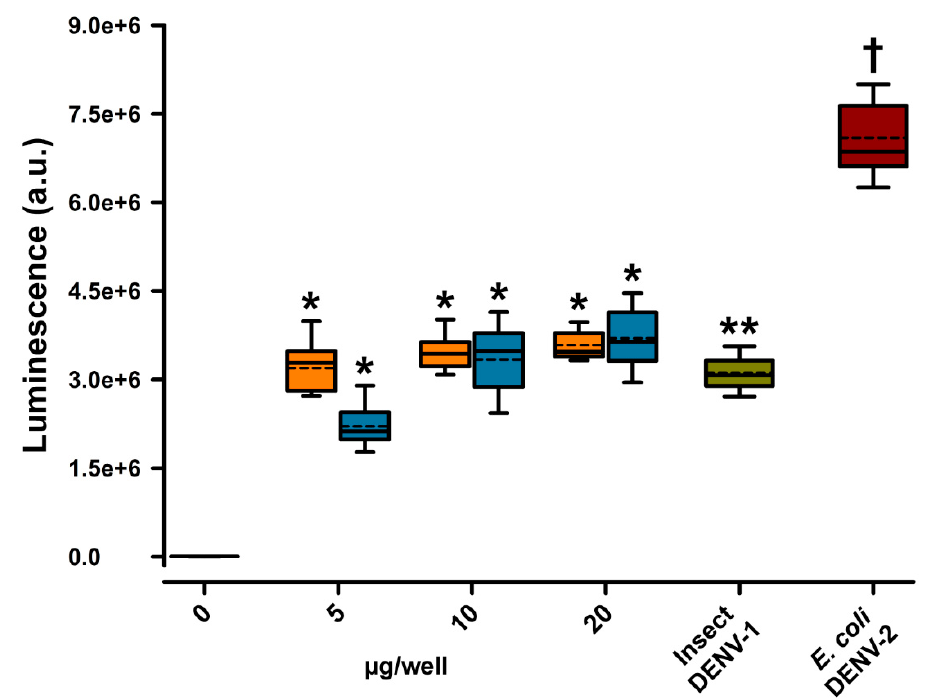
Figure 3. Recognition of synthDENVElope proteins by a monoclonal anti-DENV-2 antibody. A murine monoclonal (NYRDeng2) antibody directed against DENV-2 viral particles was capable of binding to both syDENV-1 (orange boxes) and -2 (blue boxes) proteins in an indirect ELISA test. Luminescence signals (arbitrary units) generated by this interaction were similar to levels generated when the antibody was incubated with the recombinant DENV-1 E protein produced by insect cells (dark green box) but were lower than signals elicited when the recombinant DENV-2 protein expressed in E. coli (dark red box) was present in the wells. Luminescence levels in the presence of any of the synthetic recombinant E proteins were at least 1000-fold higher (2 × 10 6 vs. 0.8 × 10 3 a.u.) than those obtained as base-line levels in the absence of any E protein in the wells (left-most box at 0 µ g / well). * denotes p < 0.01 vs. 0 µ g / well; ** denotes p < 0.01 vs. 0 µ g / well and syDENV-2 5 µ g / well; and † denotes p < 0.01 vs. all other groups.